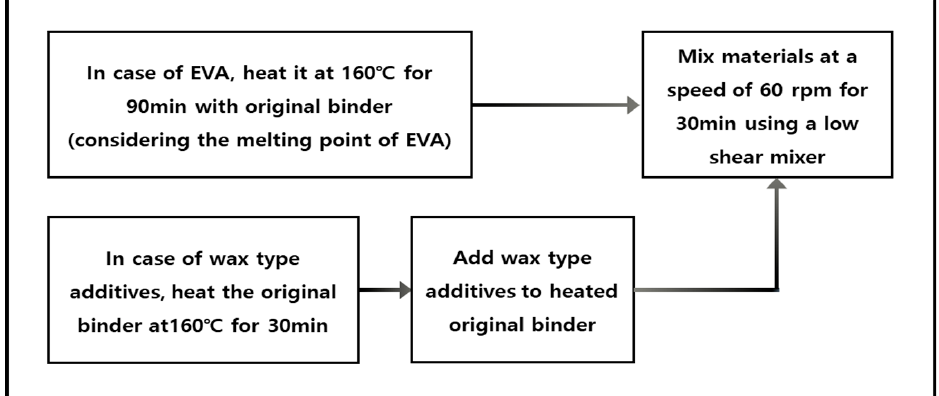
Figure 1. Production process for modified asphalt binders.